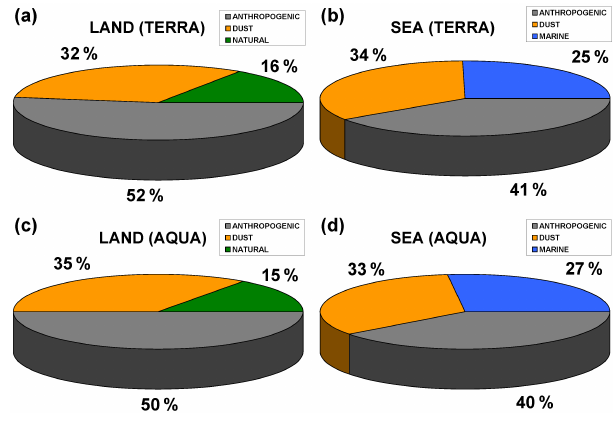
Figure 7. Relative contribution of anthropogenic aerosols, dust and fine-mode natural aerosols to the total AOD 550 over the land-covered part of the Eastern Mediterranean based on MODIS Terra (a) and MODIS Aqua (c) observations and relative contribu- tion of anthropogenic aerosols, dust and marine aerosols to the total AOD 550 over the oceanic part of the Eastern Mediterranean based on MODIS Terra (b) and MODIS Aqua (d)